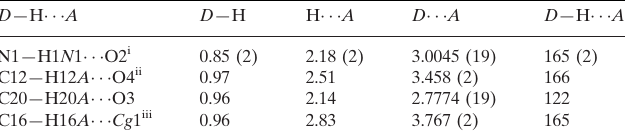
Data collection Bruker SMART APEXII CCD area-detector diffractometer Absorption correction: multi-scan ( SADABS ; Bruker, 2005) T min = 0.976, T max = 0.994 Refinement